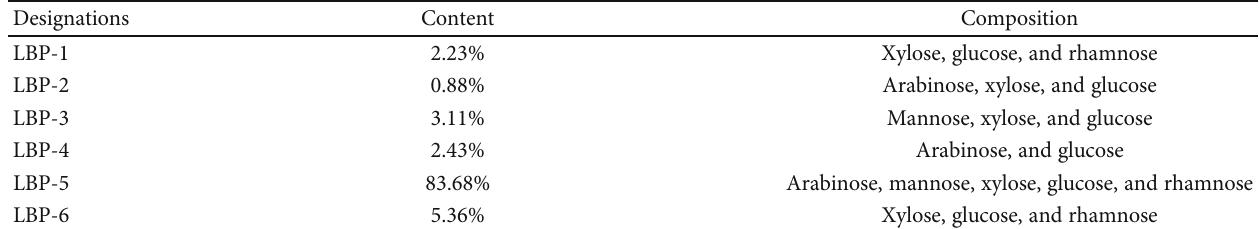
Figure 1: UV spectrum for CLBP. Table 1: Polysaccharide content at each elution